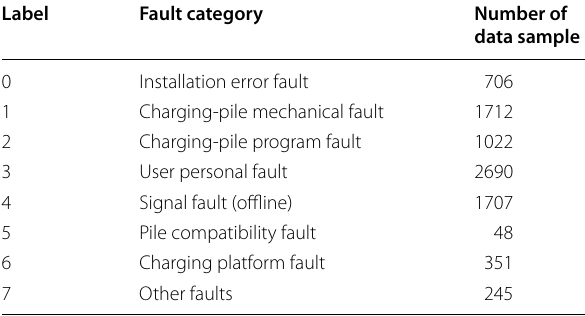
Table 3 Data amount of fault record dataset